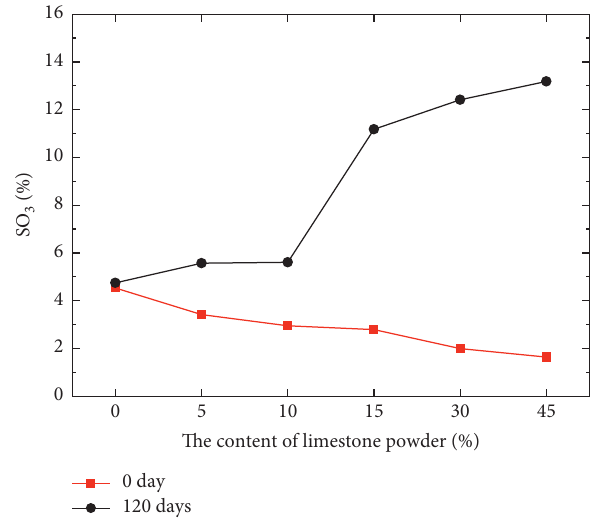
Figure 15: SO 3 content of the cathode surface for all the samples at 120 days.